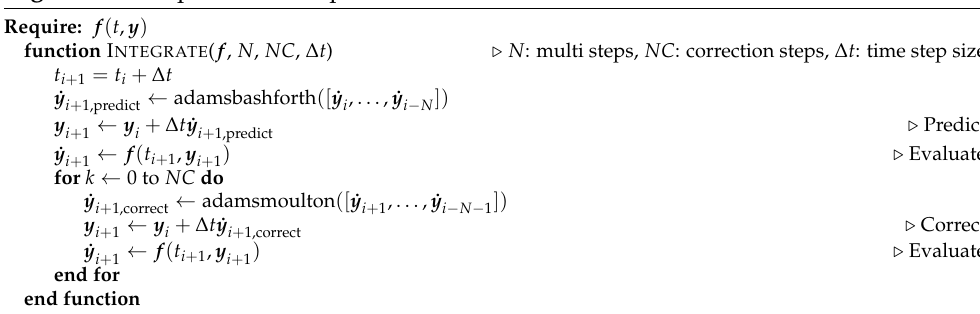
Algorithm 1 Implicit multistep solver for first order